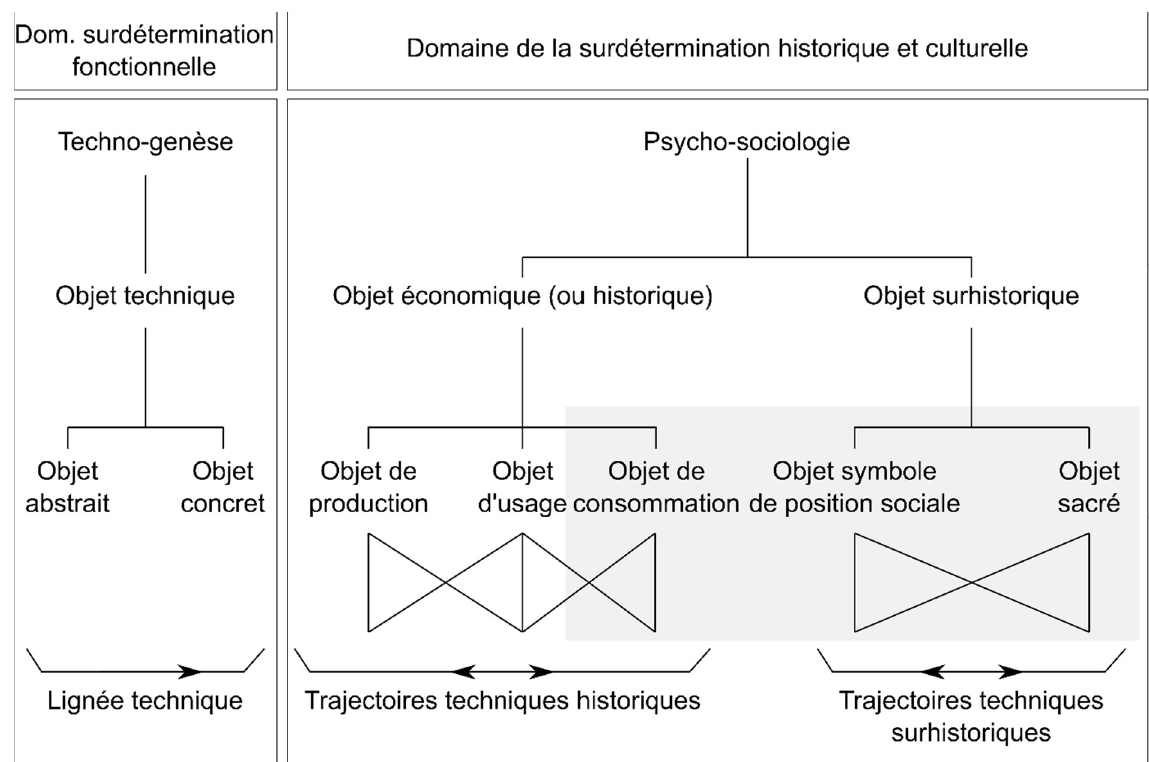
Figure 6. Deux perspectives complémentaires sur les objets de la préhistoire. La zone grise représente le chevauchement possible entre les dimensions économique et